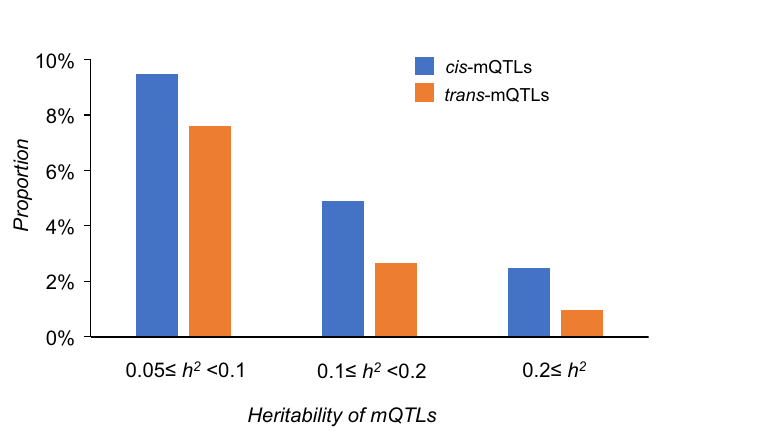
Table 1. Characteristics of the study population. Values are mean ± SD.